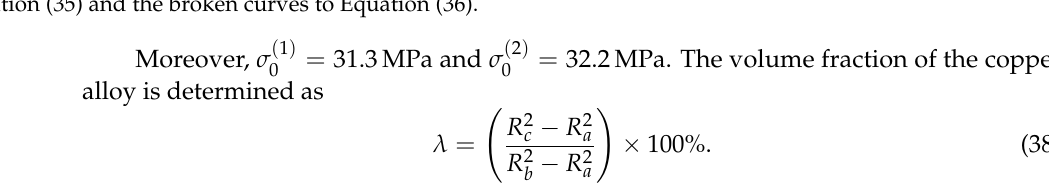
Figure 3. Comparison of the experimental data from [26], and the theoretical solution resulting from Equation (32). The solid line represents the experimental data and the broken line the theo- retical solution found using Equation (32).